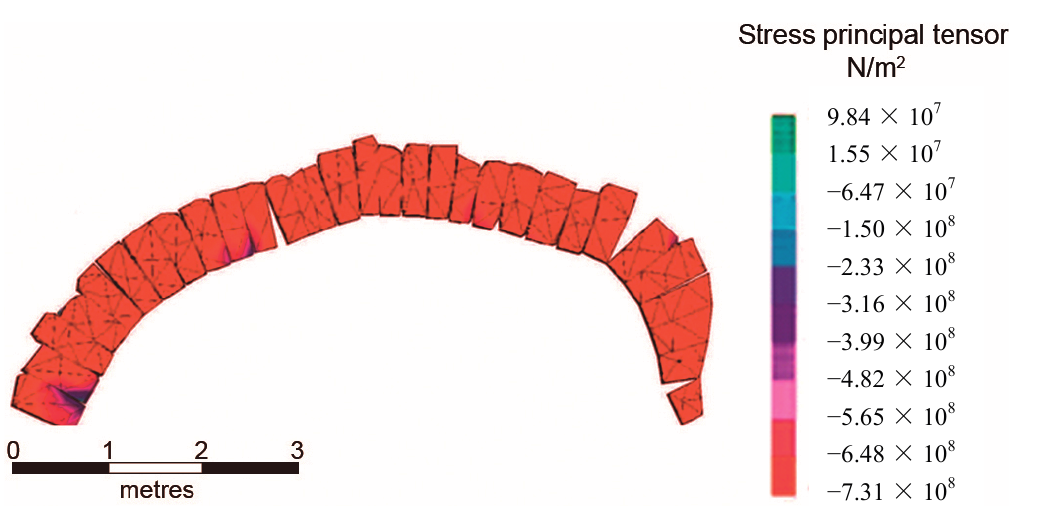
Figure 8. Distribution of stresses and the appearance of plastic hinges during the formation of a mechanism in the geometric model built from the photogrammetric